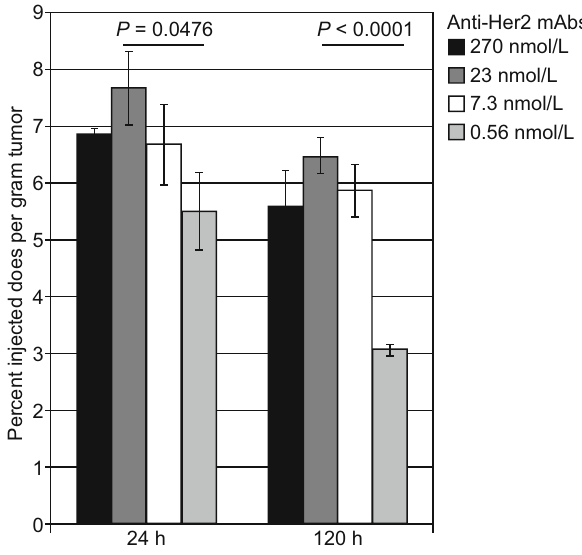
Figure 6. Tumor distribution of anti-Her2 mAbs with different af fi nities. Adapted from Rudnick et